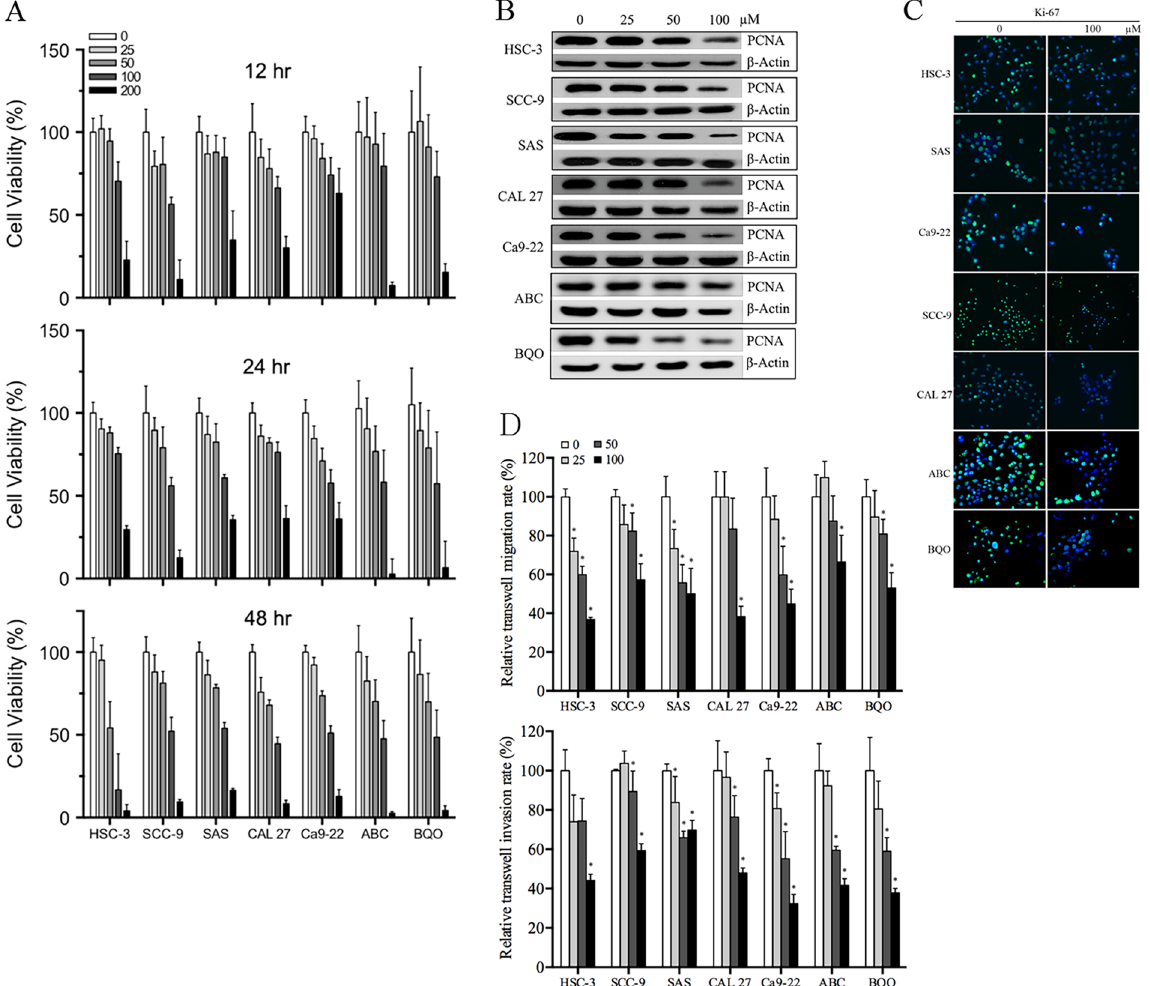
Figure 1. Inhibitory effect of CXB on OSCC tumour growth, migration and invasion in an in vitro model. ( A ) MTT-based cell viability assay, ( B ) immunoblotting of PCNA, ( C ) ICC-IF of Ki-67 (Ki-67 and DAPI showed green and blue fluorescence, respectively), and ( D ) cell migration ability was determined by the scratch (also refer Supplementary Fig. 2) and transwell assays, and invasion was analysed using a matrigel-transwell